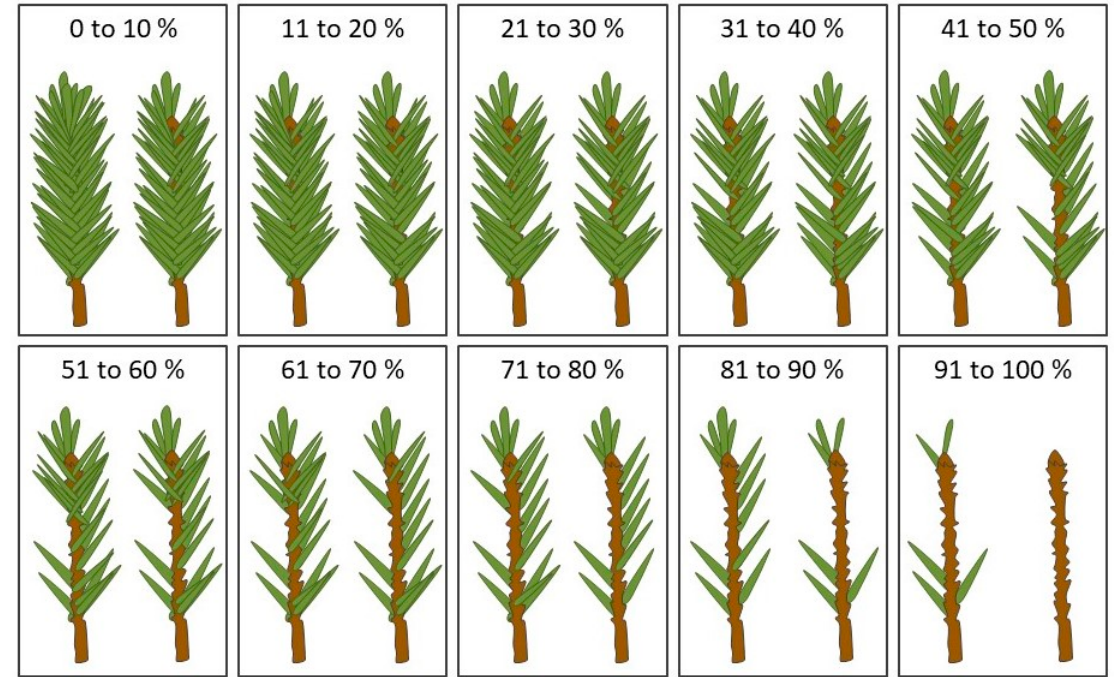
Figure 4. The methodology used to estimate the level of annual defoliation (0%–100%) based on ten defoliation classes for black spruce and balsam fir shoots.